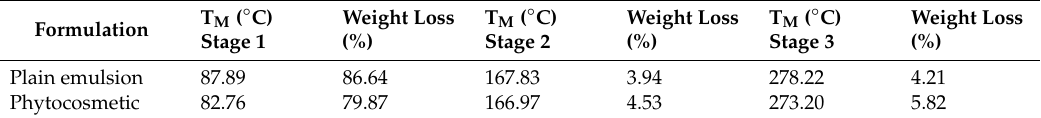
Table 4. Percentage of weight loss of components from vehicle and phytocosmetic during the three stages presented by medium temperatures (T M )